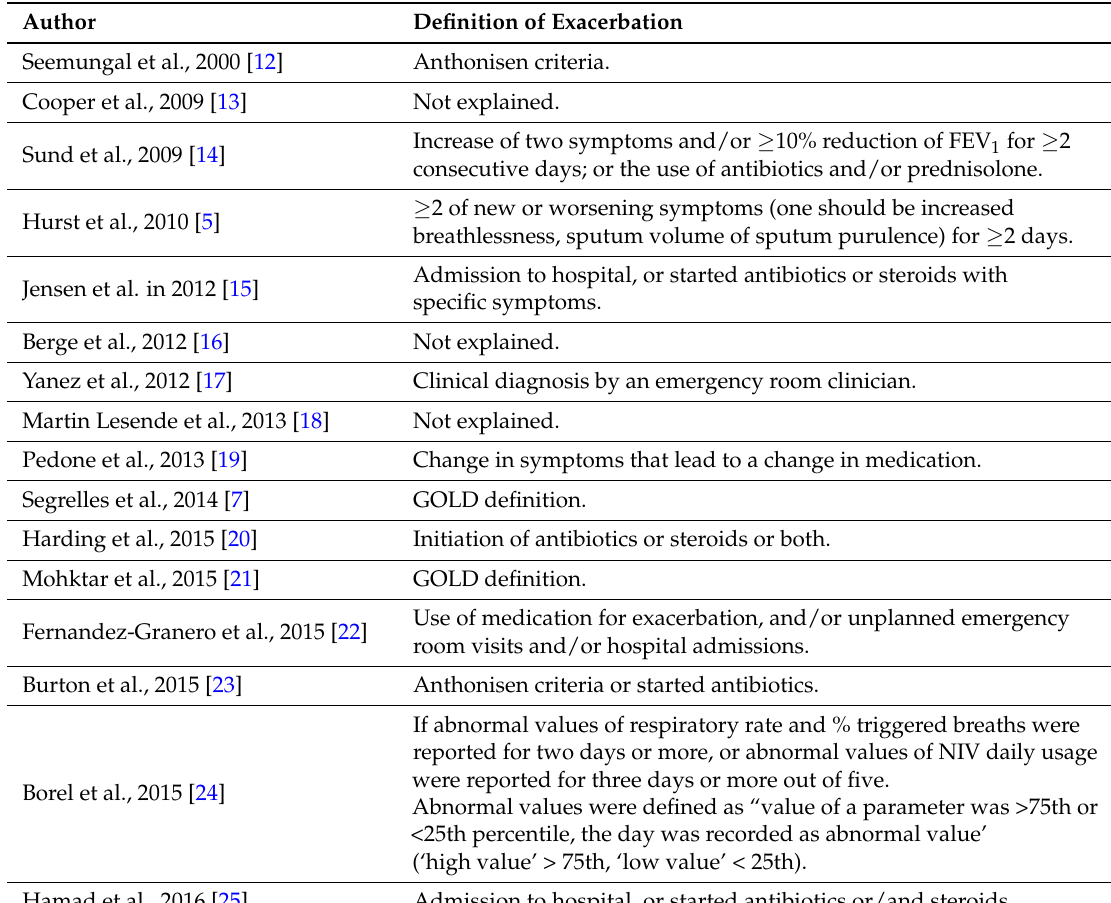
Table 2. Detailed description of the 16 included